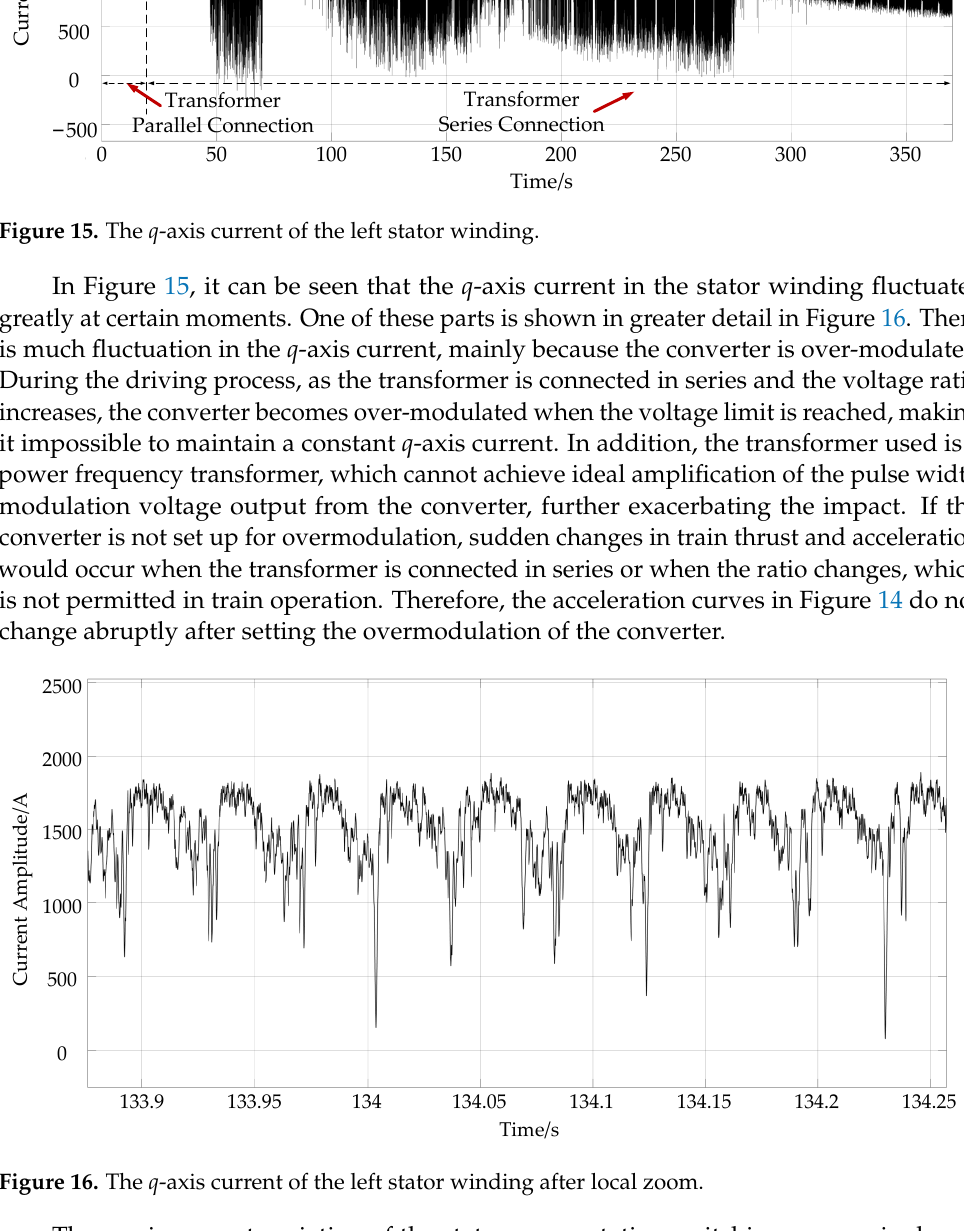
87 Figure 17. The q -axis current during stator switching. The current output from the converters at both ends is shown in Figures 18 and 19. Since the voltage drop on the cable needs to be compensated, from the prospective of the whole process, the output current of the converter at the start point decreases as the train runs, while the output current of the converter at the end point increases.